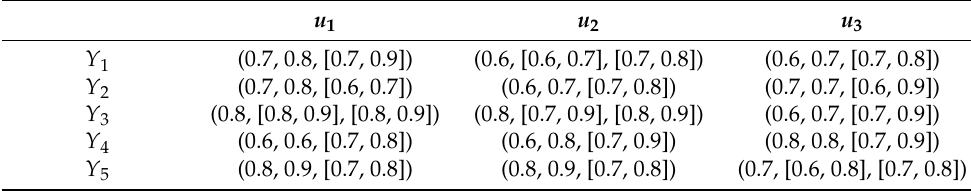
Table 1. Evaluation values of SIVFMEs provided by the three decision makers.